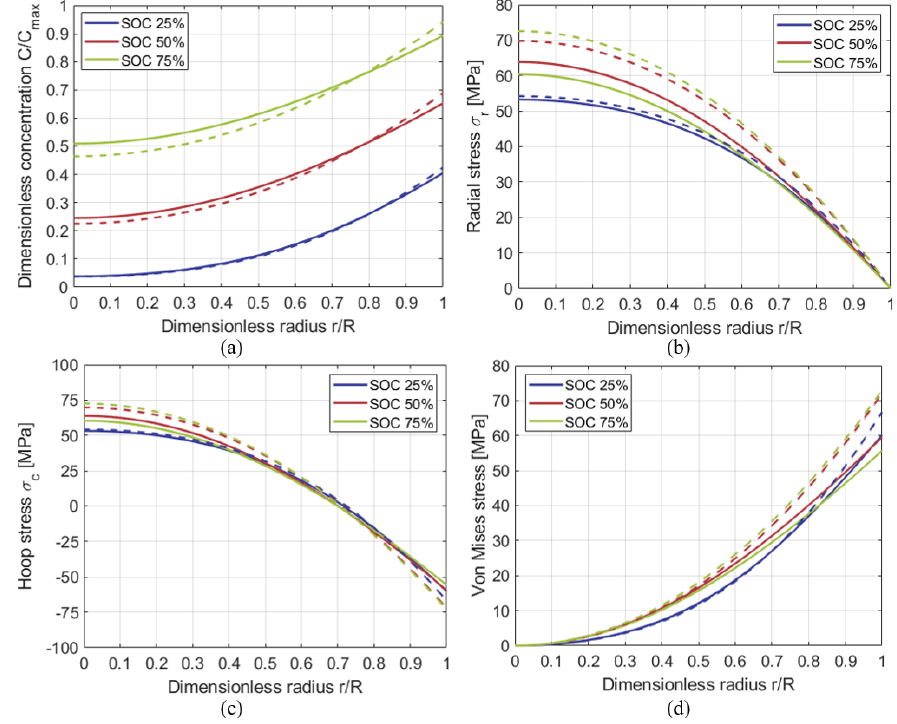
Figure 5. Lithium concentration ( a ), radial stress ( b ), hoop stress ( c ) and Von Mises stress ( d ) for different SOC levels in galvanostatic insertion in cathode material. Dashed lines refer to the uncoupled model and solid lines refer to the coupled